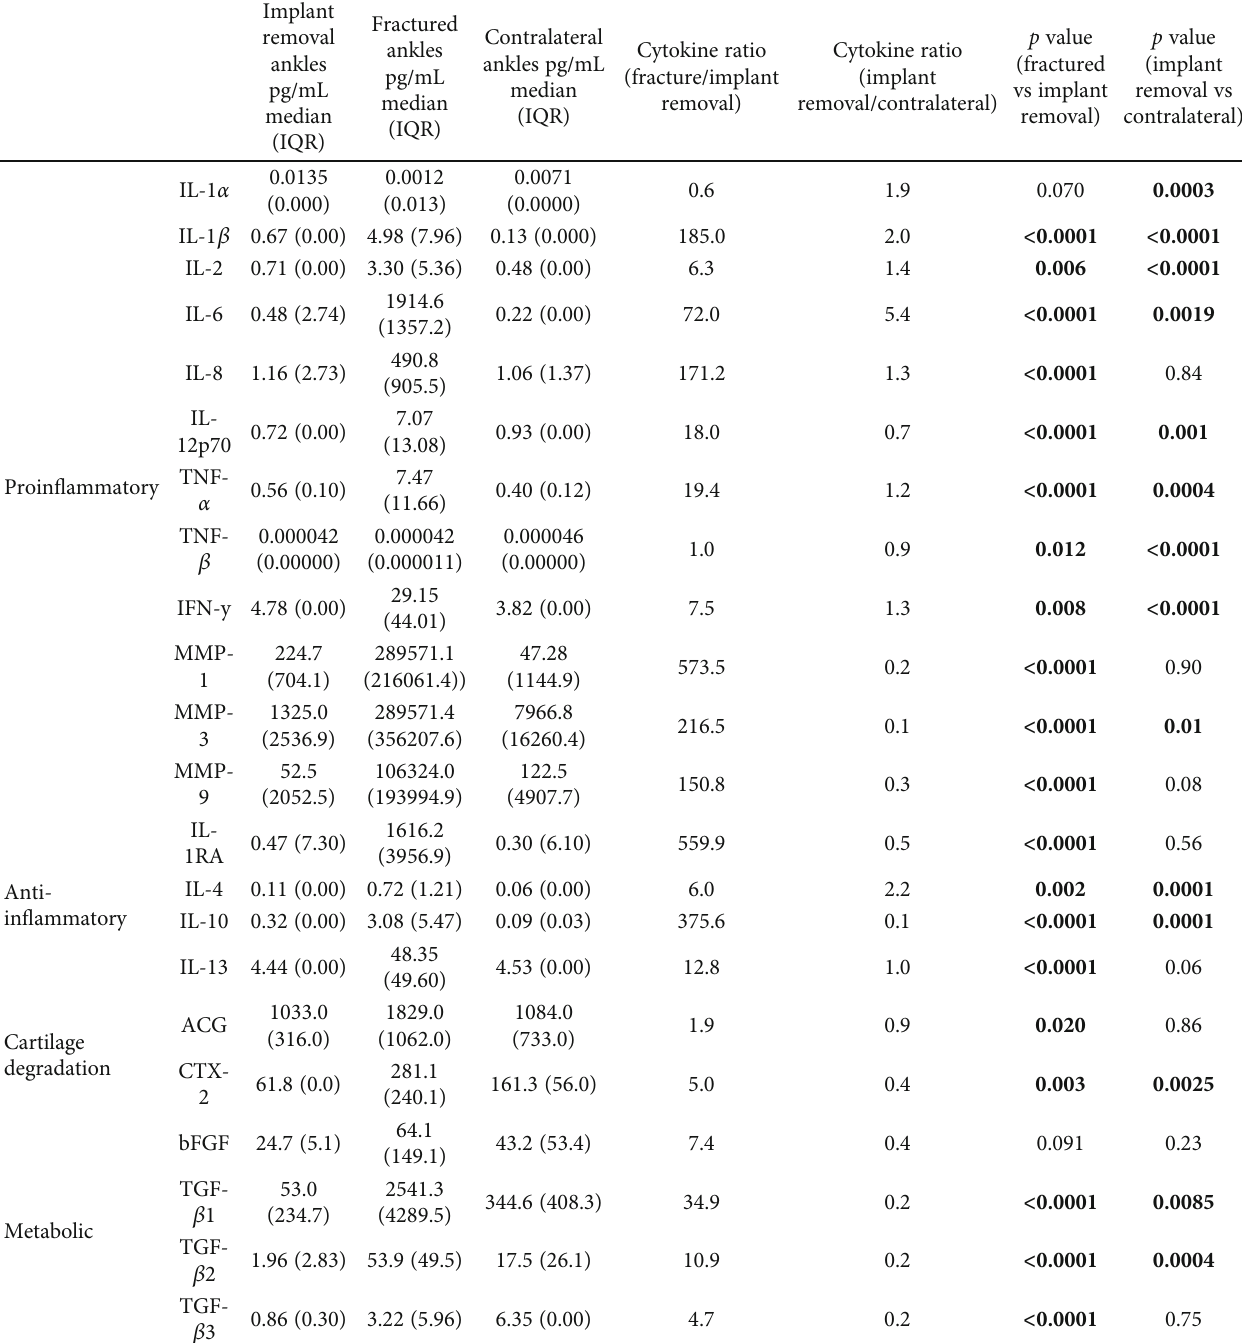
Table 2: Cytokine level in implant removal compared to fractured and healthy contralateral